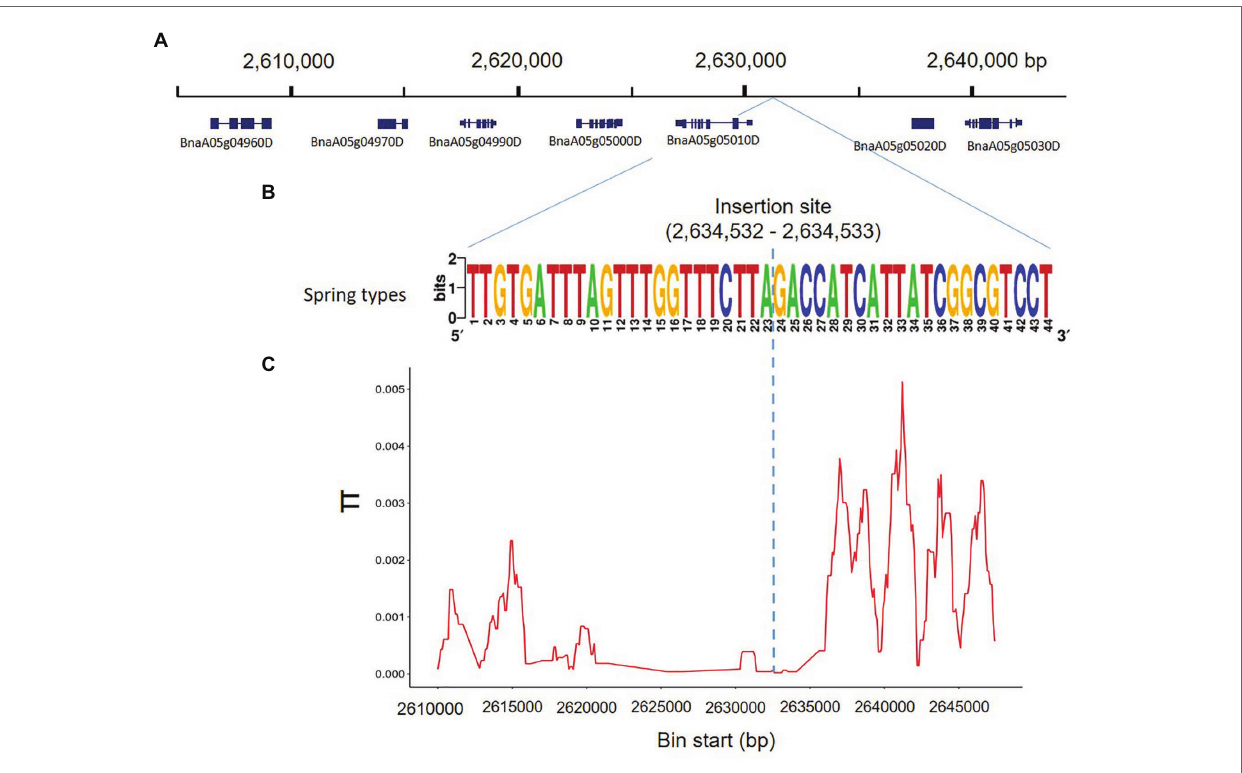
FIGURE 3 | Nucleotide diversity accross the insertion site on chromosome 5. (A) 0.4-Mb genomic region surrounding the insertion sequence, and the genes annotated in this region according to Darmor- bzh reference genome. (B) The consenus sequence covering the breakpoint of the PAV in 18 rapeseed